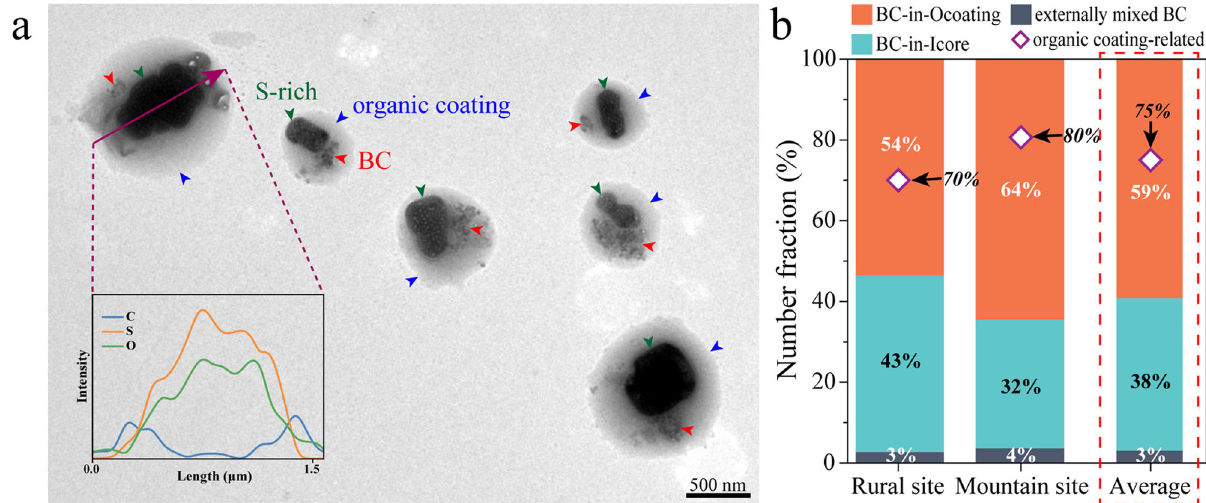
Fig. 2 Distribution of BC inside individual particles and number fractions of BC particles in the background air. a A typical TEM image of BC-in-Ocoating particles in the background air at low magni fi cation. The red, green, and blue arrows indicate BC, S-rich particles, and organic coatings. Line scanning of a typical secondary particle with organic coating by the high-angle annular dark- fi eld scanning TEM (HAADF-STEM) shows elemental pro fi les of C, S, and O across the particle. b Number fractions of BC-containing particles with different distributions of BC at two background sites. The purple diamonds indicate individual BC-containing particles with the LLPS.